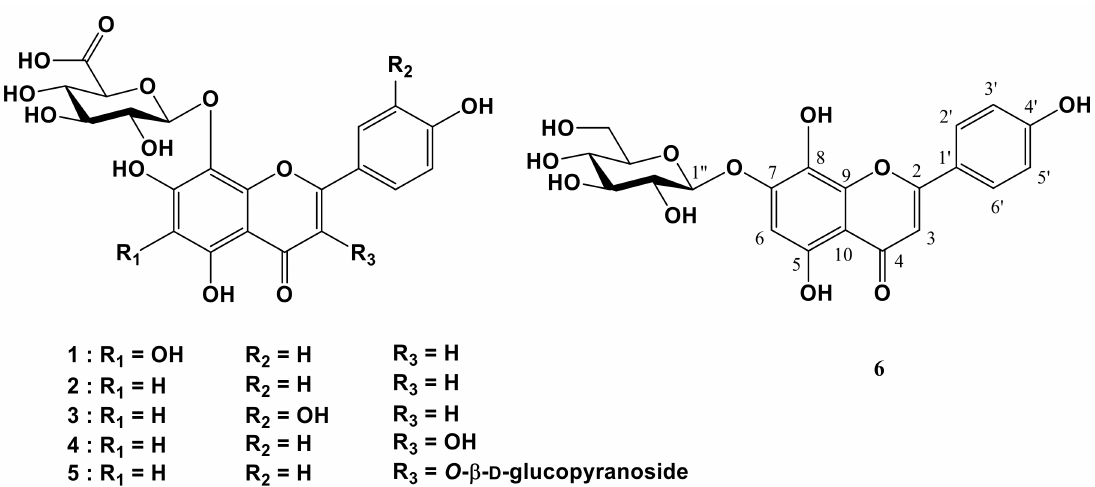
Figure 1. Chemical structures of flavonoids 1 – 6 isolated from the aerial parts of Malva verticillata . Com 1 , a yellow amorphous powder (pyridine- d 5 and D 2 O), exhibited UV